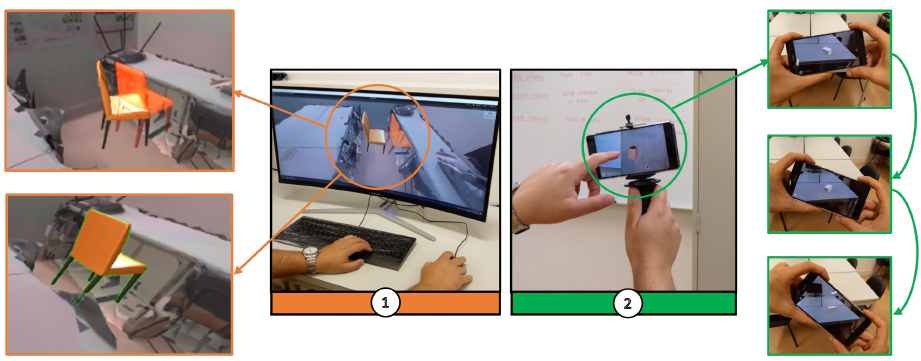
Figure 3. Virtual content configuration: Left (1) —VAT model using a desktop computer; Right (2) —physical space using a handheld device.